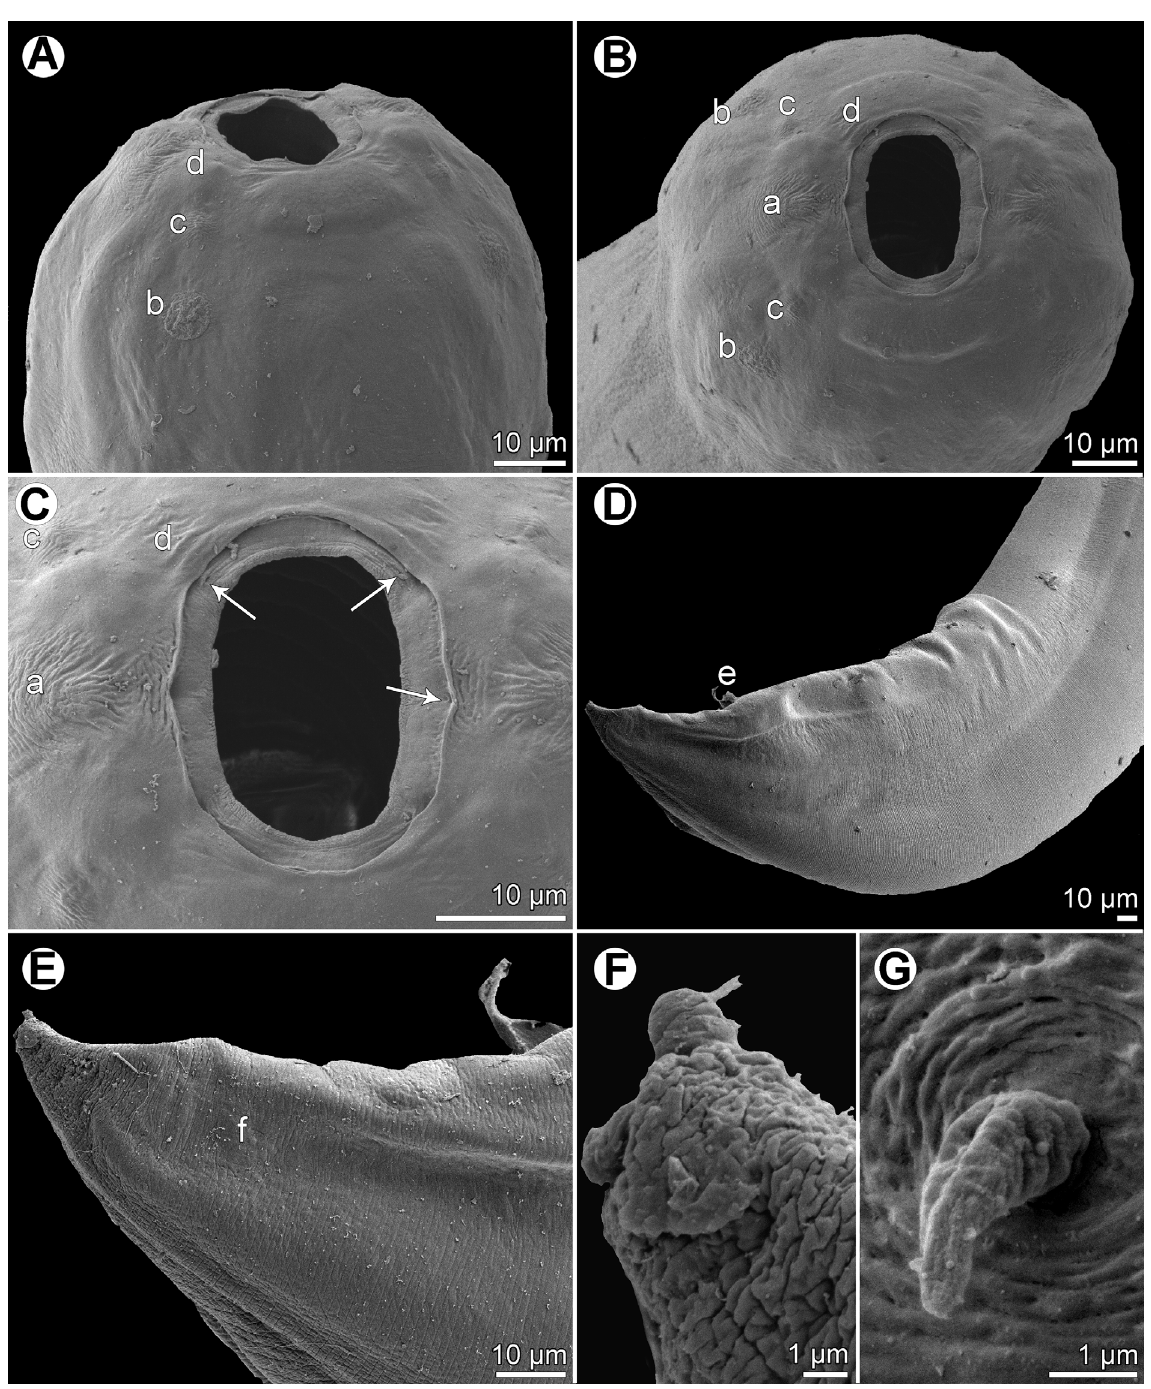
Figure 8. Procamallanus ( Spirocamallanus ) synodi n. sp., scanning electron micrographs. (A, B) Cephalic end, subdorsoventral and apical views, respectively; (C) region of oral aperture, apical view (arrows indicate circumoral pores); (D) posterior end of male, lateral view; (E) tail of male, lateral view; (F) tail tip of female, lateral view; (G) deirid. (a) amphid; (b) cephalic papilla of external circle; (c) cephalic papilla of middle circle; (d) cephalic papilla of internal circle; (e) cloaca; (f)